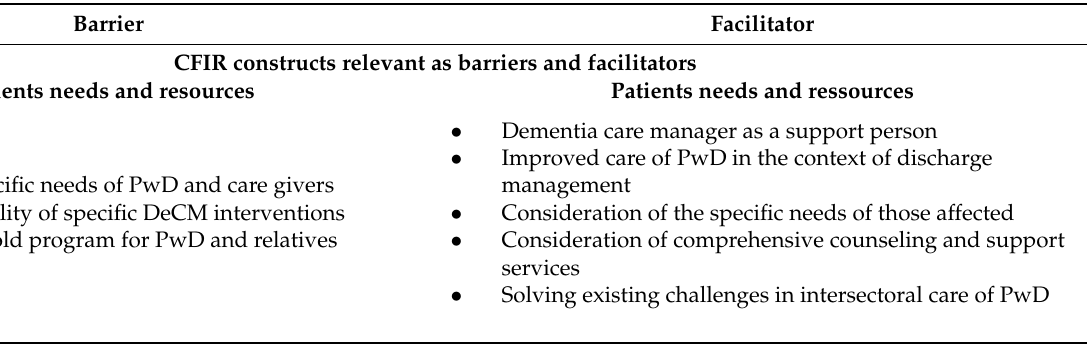
Table 1. Summary of the key results, by barriers and